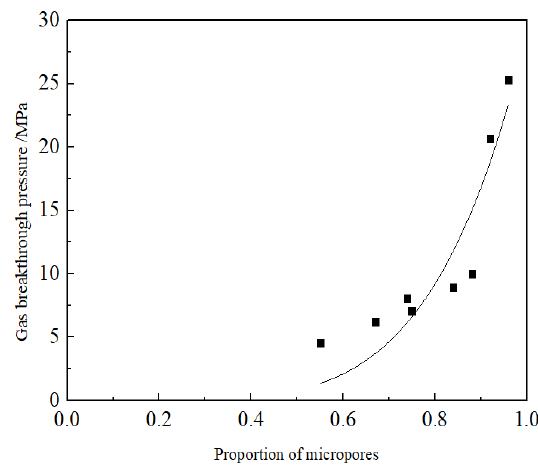
Figure 12. Gas breakthrough pressure vs. proportion of micropores.